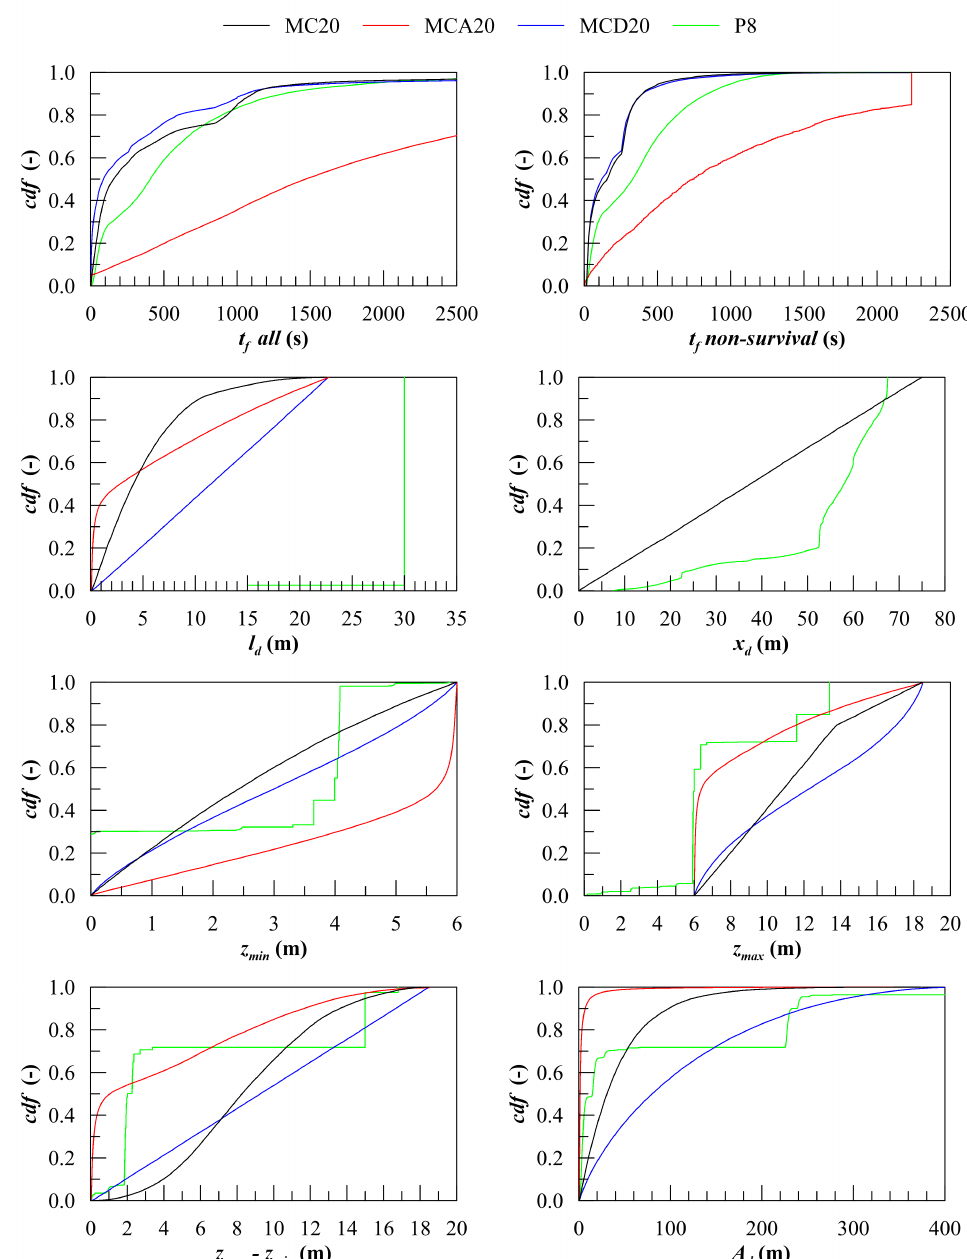
Figure 7. Cumulative density functions of damage dimensions, location, and time-to-flood related to the tested database-generation